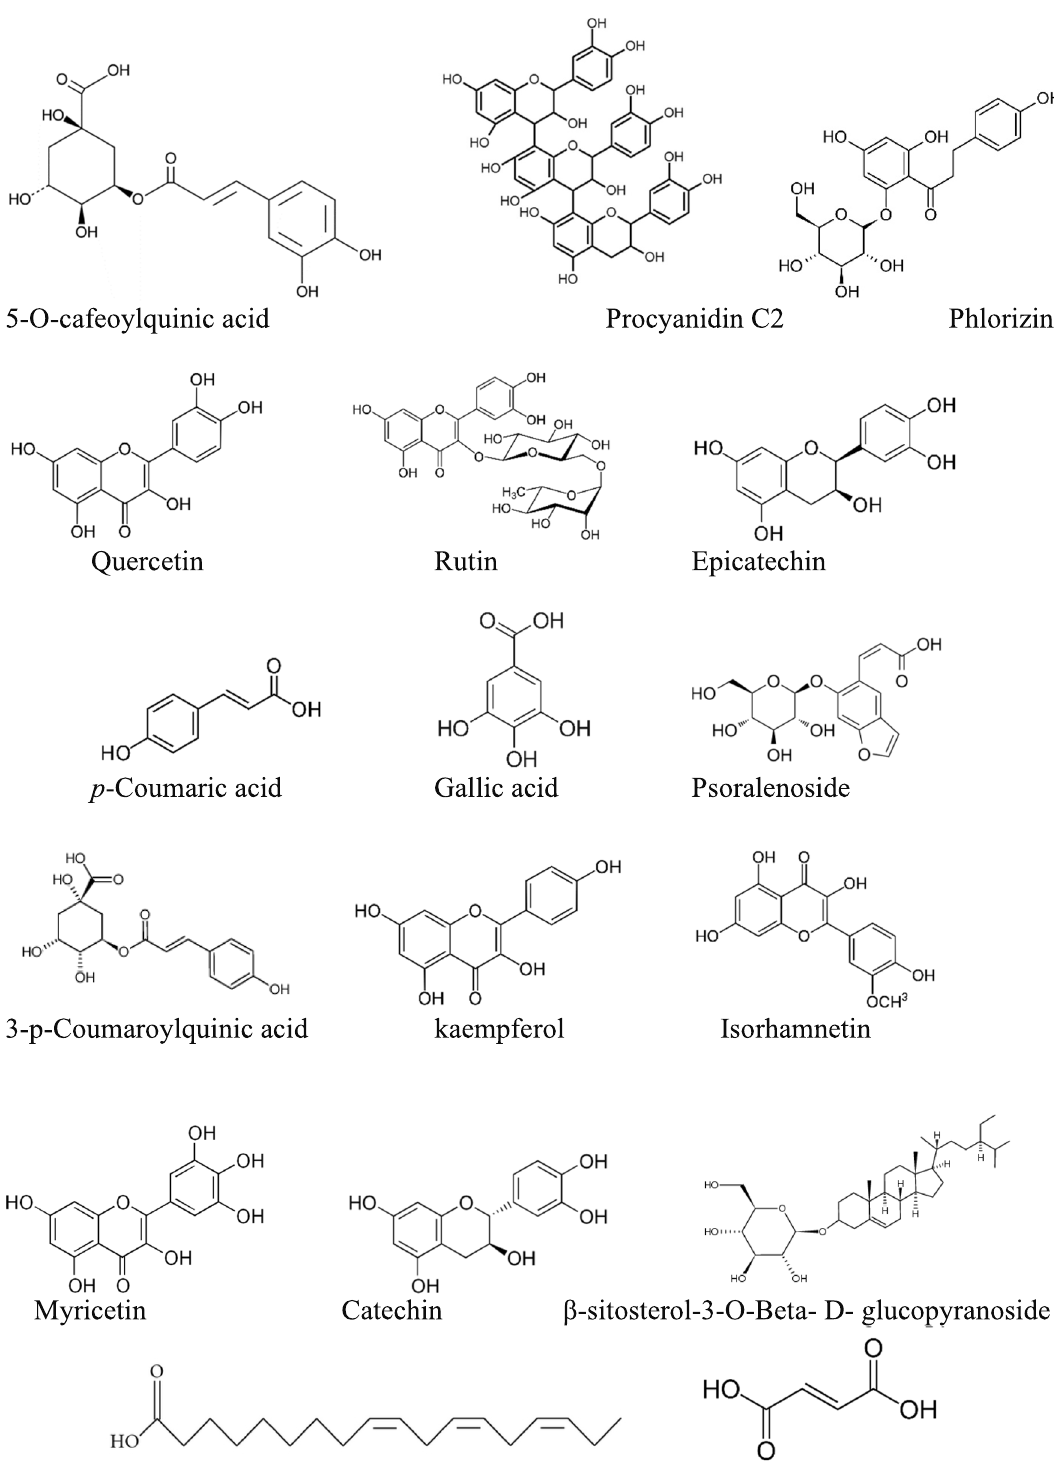
Fig. 2 Important phytochemicals present in under-utilized, fruits of the northern